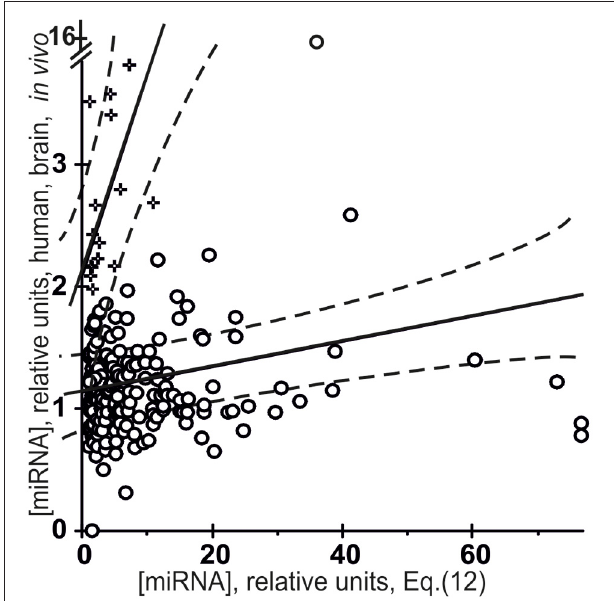
FIGURE 9 | Verification of the “limiting stage” approximation [Equation (12), the x -axis] using the final Equation (5) and independent experimental data (the y- axis) taken from the Sestan Brain Atlases (Kang et al., 2011). Results of a cluster analysis performed using STATISTICA (Afifi et al., 2003) on the miRNA abundance in the human brain taken from the Sestan Brain Atlases (Kang et al., 2011) vs. in silico estimates [Equation (12)] within the framework of the “limiting stage” approximation. The major cluster ( (cid:8) ) includes 294 miRNAs (92%), which have the lowest mean miRNA abundance in vivo , [miRNA] = 1 . 2 ± 1 . 0, and a high mean [miRNA/Ago] affinity estimated [Equation (12)], 9 . 1 ± 12 . 7, and the lowest statistically significant correlation coefficient r = 0 . 14 ( α < 0.025). The minor cluster (+) includes 24 miRNAs (8%) with the highest mean miRNA abundance in vivo , 2 . 7 ± 0 . 7, and a lowest mean estimate of [miRNA/Ago] affinity in silico [Equation (12)], 3 . 5 ± 2 . 8, and the highest correlation coefficient r = 0 . 66 ( α < 0 . 001). Dashed curves and solid lines as in the legend to Figure 3 .